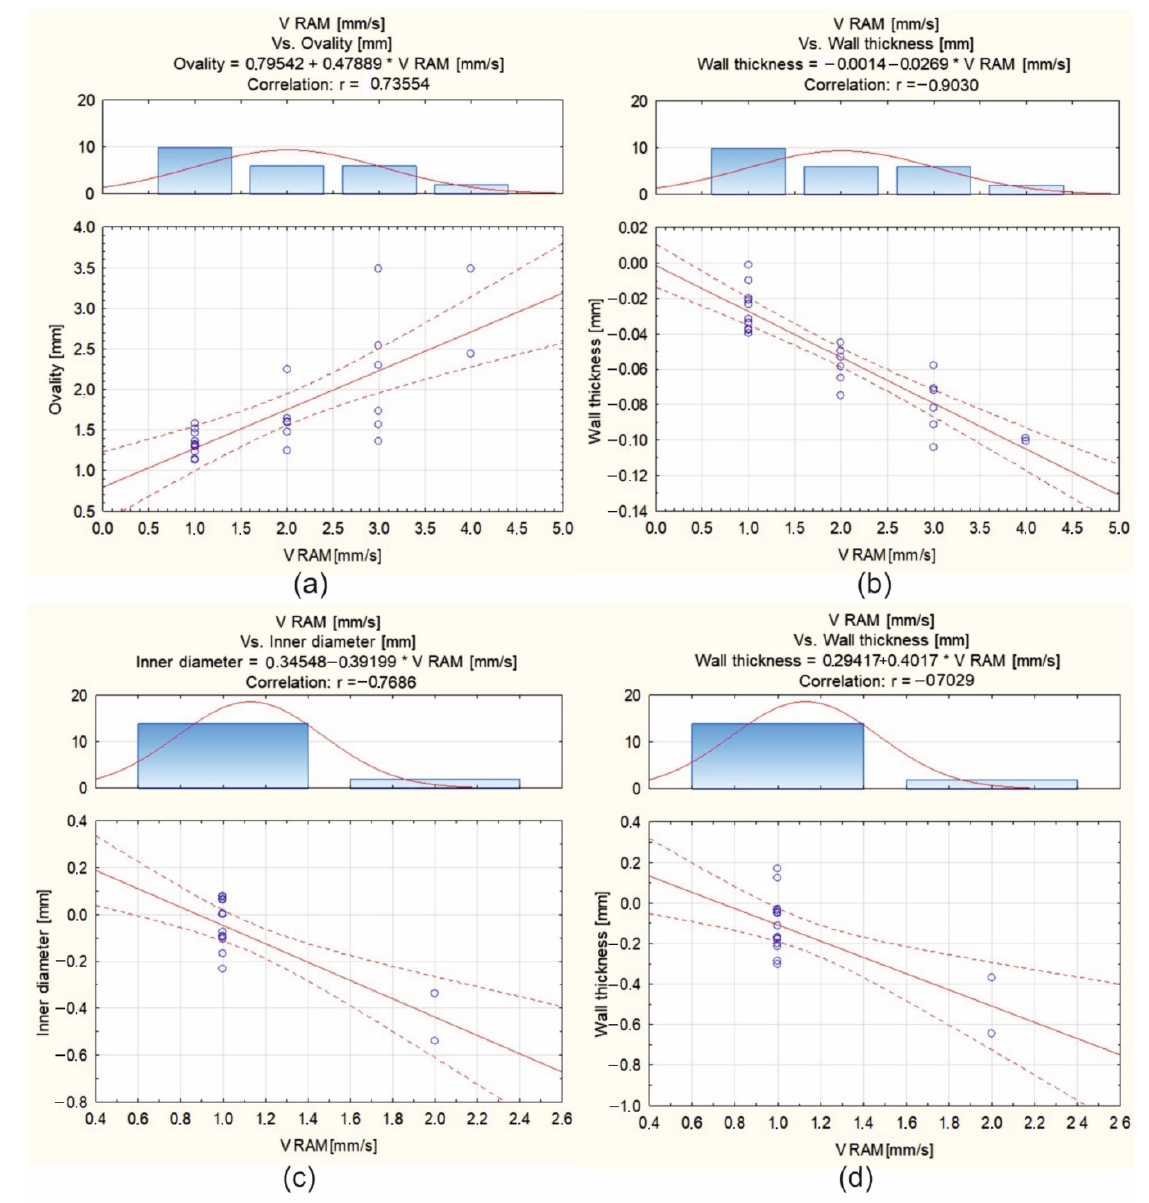
Figure 22. Scatterplots for optically scanned tubes of Ø50 × 2 mm extruded from 7021 alloy through porthole dies for different billet temperatures (480 °C, 500 °C, 510 °C and 520 °C) and different ram speeds (1.5, 2, 3 and 4 mm/s): die 1—ovality and wall thickness deviations a) , b ), and die 2—inner diameter and wall thickness deviations c) , d ).